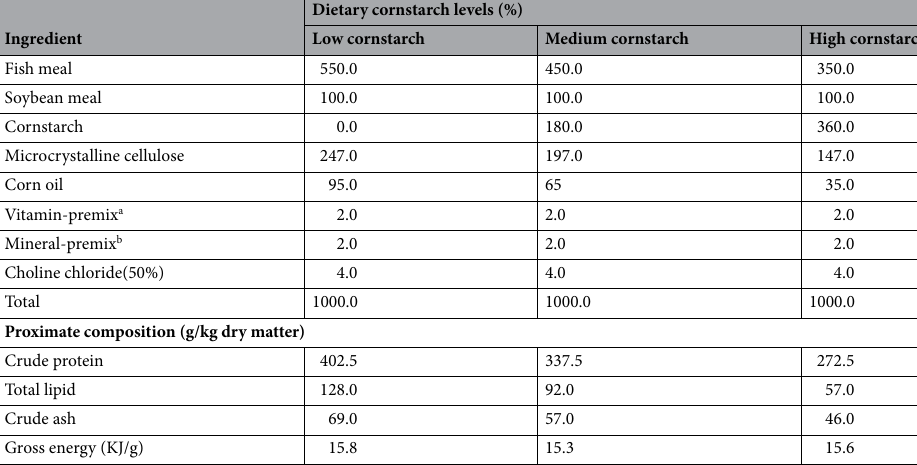
Table 1. Diet formulation and chemical composition of experimental diets (g/kg dry matter). a Vitamin premix (mg/kg diet): retinol acetate 30 mg; cholecalciferol 5 mg; alpha-tocopherol 60 mg; ascorbic acid 600 mg; vitamin K3 7 mg; thiamin 20 mg; riboflavin 20 mg; pyridoxine HCL 12 mg; vitamin B12 0.05 mg; inositol 100 mg; pantothenic acid 50 mg; niacin acid 35 mg; folic acid 8 mg; biotin 0.06 mg. b Mineral premix (mg or g/kg diet): KI (1%) 60 mg; CoCl 2 ·6H2O (1%) 7 mg; CuSO 4 ·5H 2 O 20 mg; FeSO 4 ·H 2 O 300 mg;